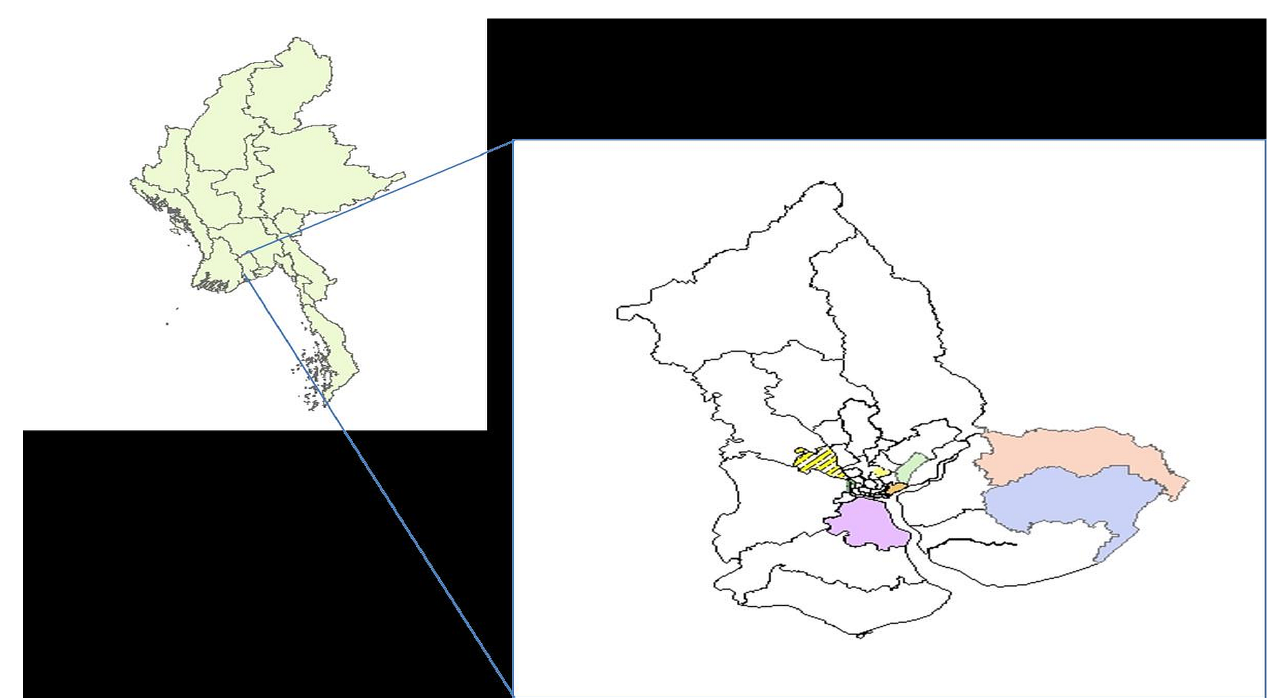
Figure 2. Randomly selected nine townships for the Japanese encephalitis survey, Yangon region, Myanmar (2019).